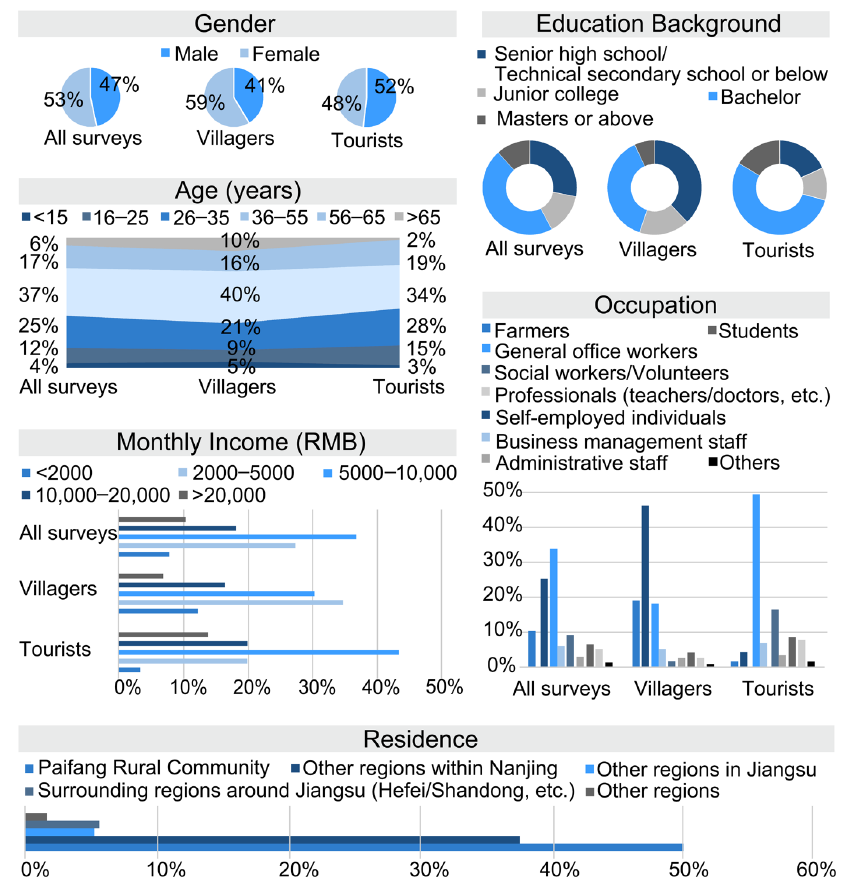
Figure 4. The demographic information of the